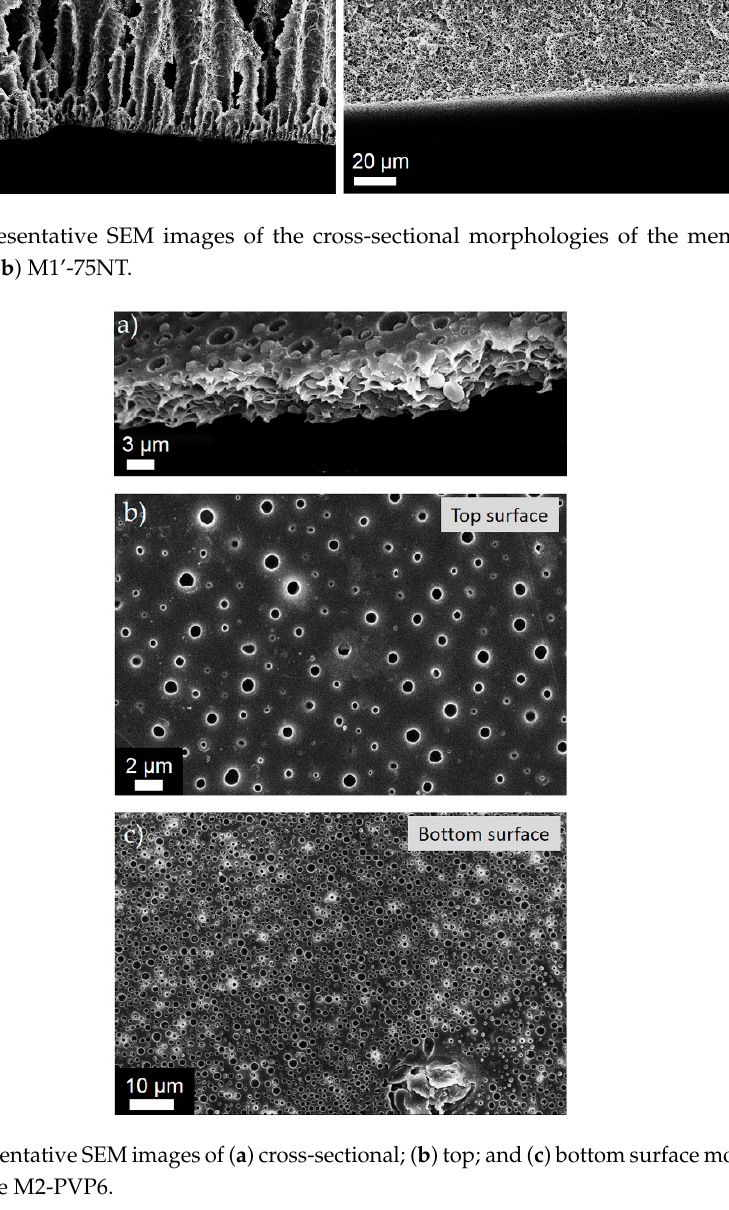
Table 3. Preparation of membranes with 70/30 w / w PDSPP/SPDSPP in NMP at 5% or 15% w / w , addition of PVP or PEG at 12.5% w / w final concentration, casting at 80 °C until 75% w/w total final polymers’ concentration and immersion in H 2 O at 60 °C for 3 h.